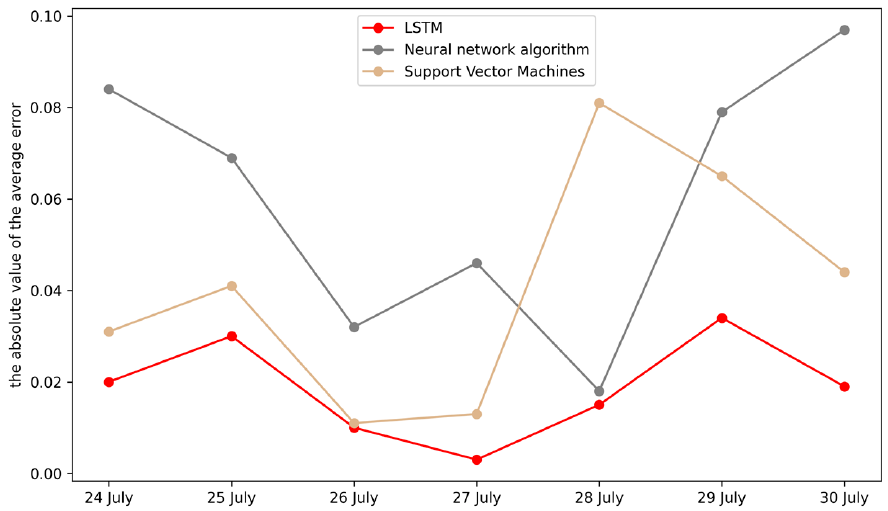
Figure 11. Prediction error in the second highest load rate of each algorithm.